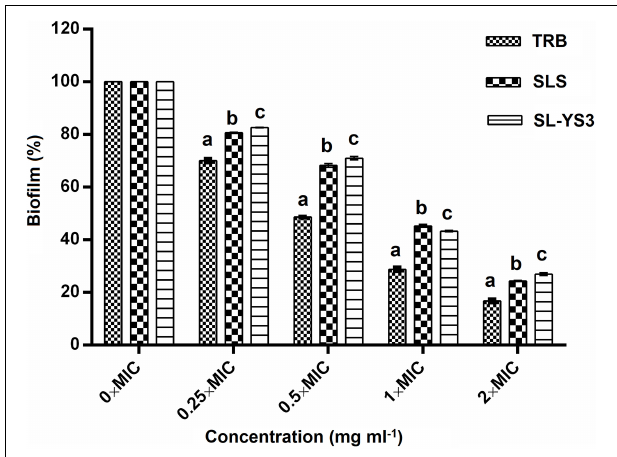
FIGURE 6 | Dispersal of pre-formed biofilms of T. mentagrophytes by the sophorolipid produced by R. babjevae YS3 (SL-YS3), sophorolipid standard 1, 4 (cid:48)(cid:48) -sophorolactone 6 (cid:48) ,6 (cid:48)(cid:48) -diacetate (SL-S), and terbinafine (TRB). Data are percentage of the mean of triplicates with respect to control. Error bars represent standard deviation. Different letters within each concentration indicate significantly different values as per ANOVA-LSD.